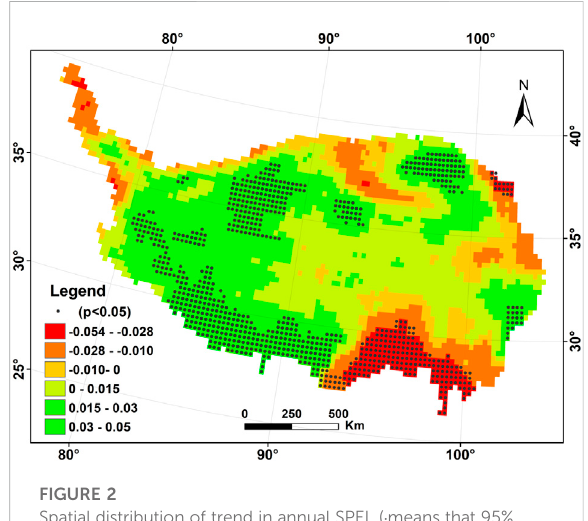
FIGURE 2 Spatial distribution of trend in annual SPEI. ( · means that 95% of the signi fi cance test has